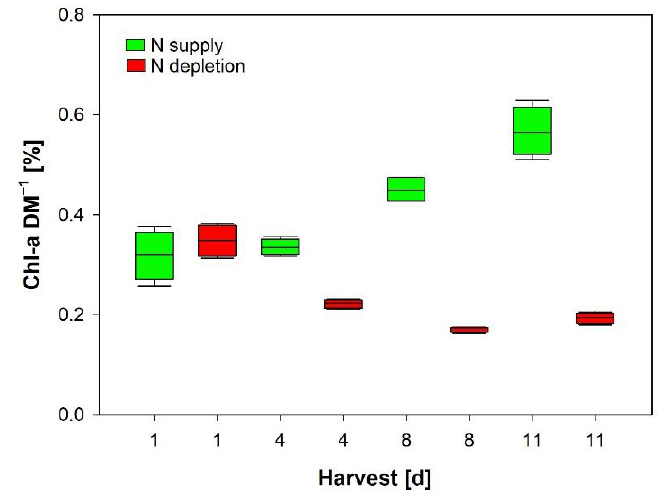
Figure 3. Significant changes of in vitro chl-a per DM (percent values) during cultivation of Limnospira fusiformis supplied with full Zarrouk medium and in nitrogen-depleted medium (rm-Anova with time and nitrogen supply as factors). Mean and standard deviation (n = 4).